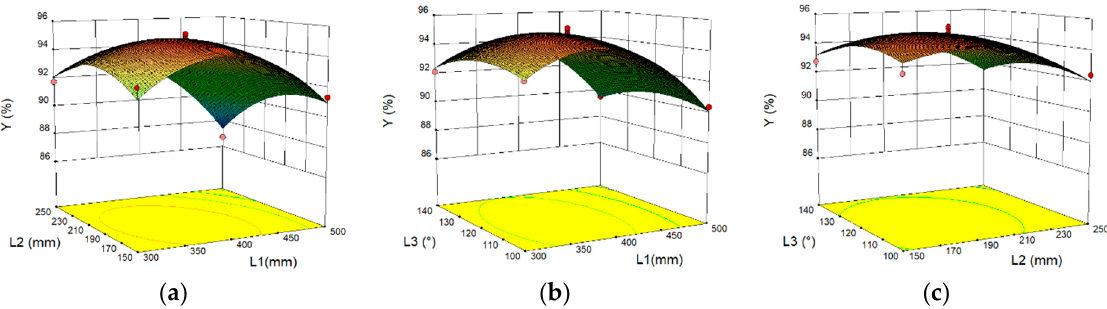
Figure 7. Index response surface analysis of test factors. ( a ) Y (L 1 , L 2 , 120), ( b ) Y (L 1 , 200, L 3 ), ( c ) Y (400, L 2 , L 3 ).